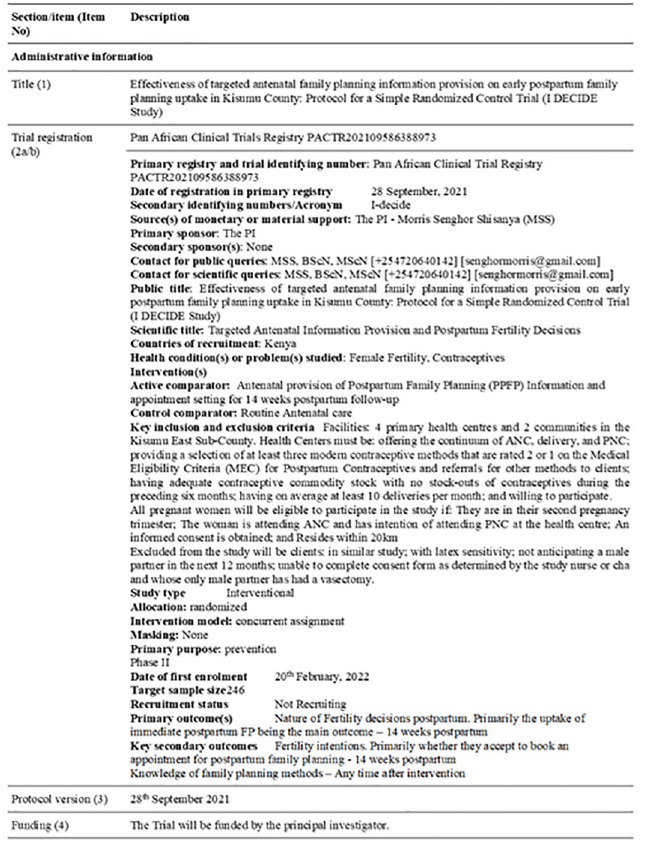
Fig 4. Trial registration